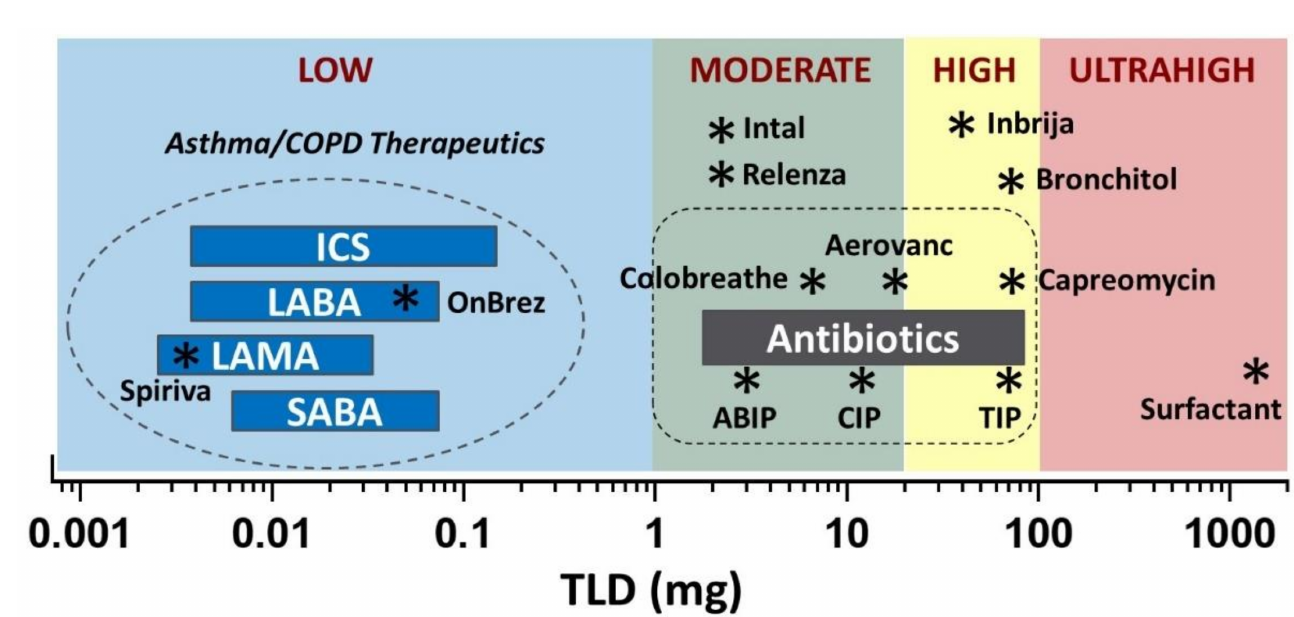
Figure 2. The total lung dose, TLD (*) of various inhaled drugs. The TLD is divided into low, moderate, high, and ultrahigh dose categories. Abbreviations: ICS, inhaled corticosteroid; LABA, long-acting beta-agonist; LAMA, long-acting muscarinic antagonist; SABA, short-acting beta-agonist; ABIP, amphotericin B inhalation powder (Nektar Therapeutics, San Francisco, CA, USA); CIP, Ciprofloxacin DPI (Bayer, Leverkusen, Germany); TIP, TOBI Podhaler (Novartis, Basel,